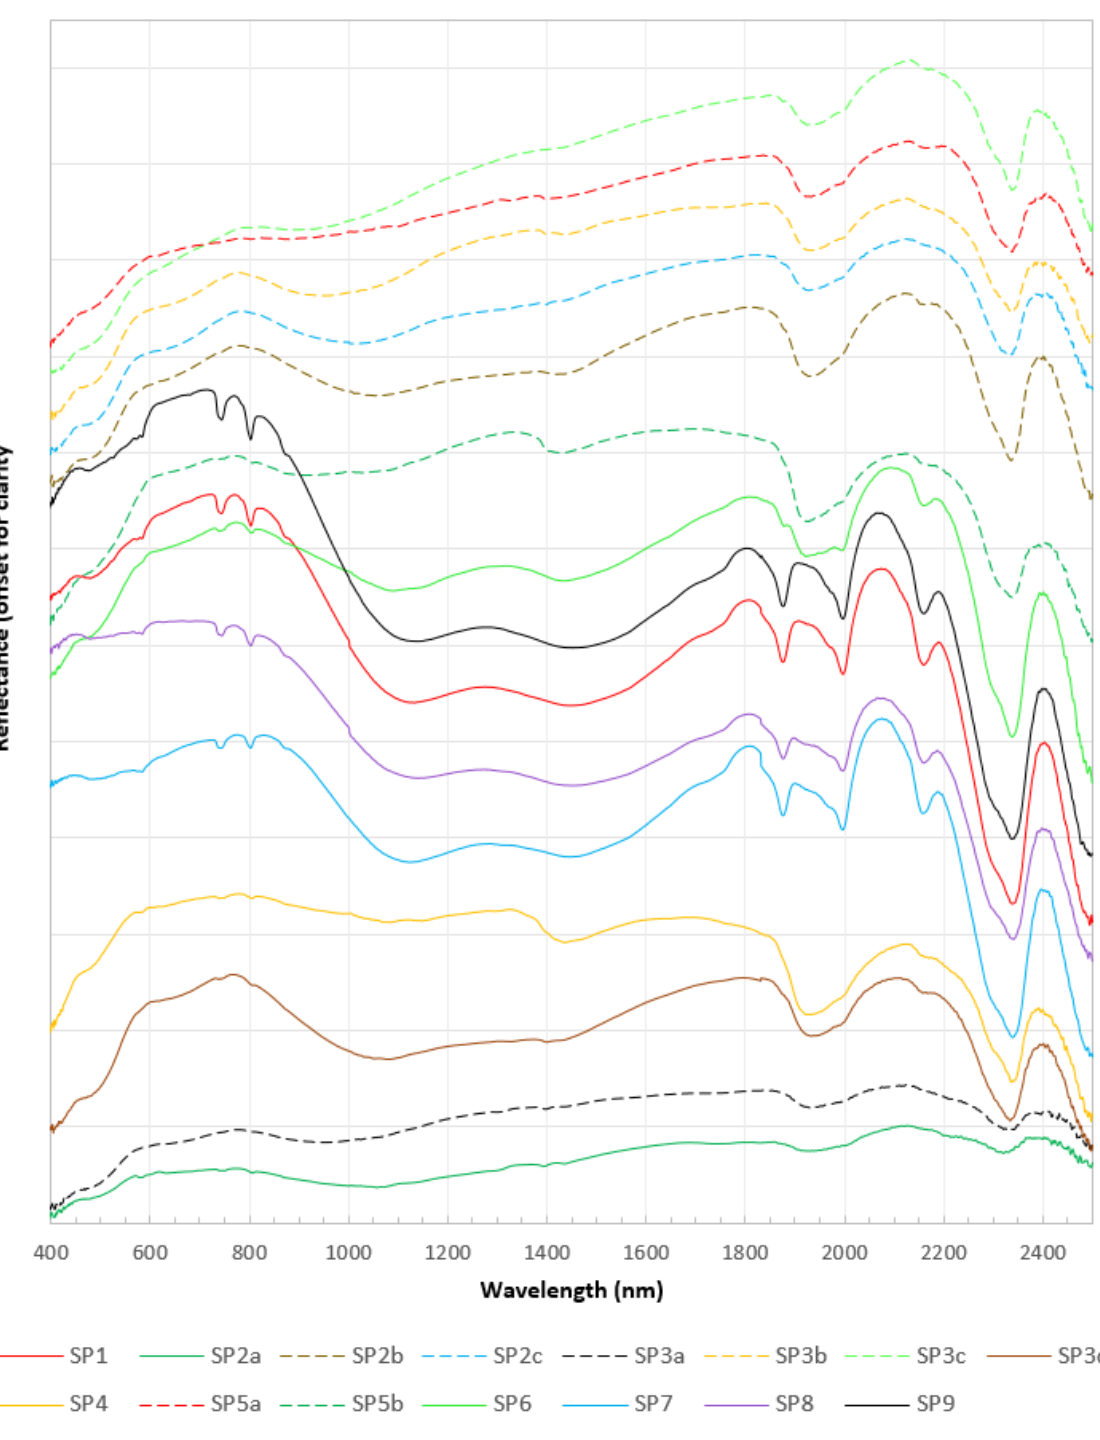
Figure 7. ASD spectral profiles of the samples are shown in Figure 3. Some of the samples show diagnostic absorption features of Nd at ~580, ~740, and ~810 nm. The strength of these features is highest in SP9, followed by SP1, SP8, and SP7, reflecting the highest concentration of Nd and associated REEs in the samples. Other samples have shown weaker to no Nd absorption features. The broad valley between 1000 and 1500 nm represents the iron content in the carbonatite (possibly ankerite mineral), and the diagnostic absorption features of calcite at 1875, 1995, and 2338 nm. Four of the seven carbonate absorption bands common to the spectra of all anhy- drous carbonate minerals are conspicuous in the ASD spectral profile of almost all the samples. The depth of these absorption features may vary, corresponding to the varying